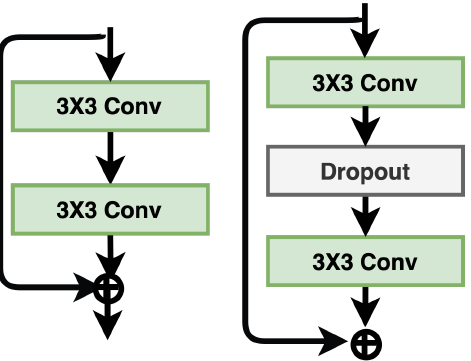
Figure 10. The basic schematic of a Wide ResNet block with and without a dropout